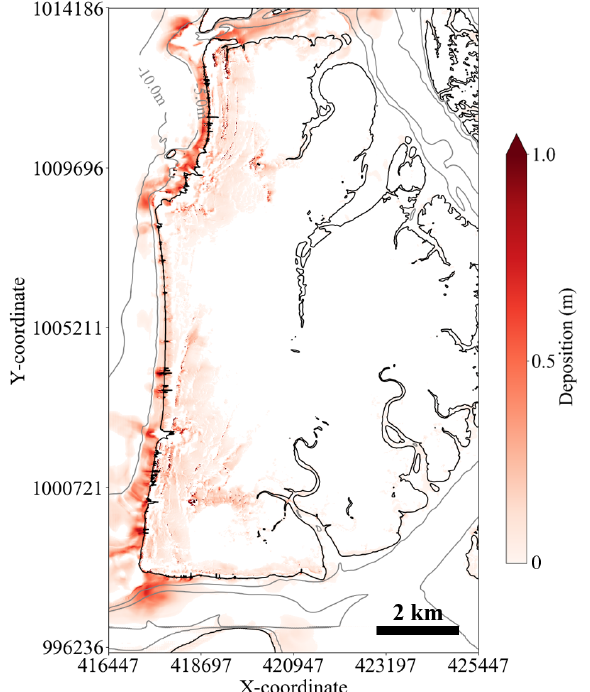
Figure 15. Sediment distribution derived from the simulation (showing depth contours at 5m intervals in the sea